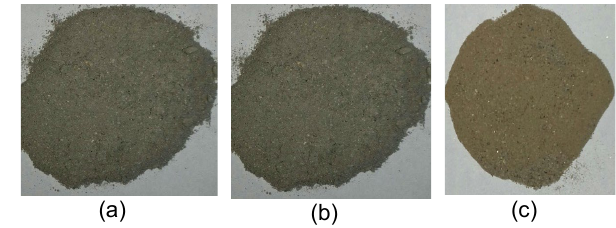
Figure 6. Sample of different types of dusts: (a) Brick